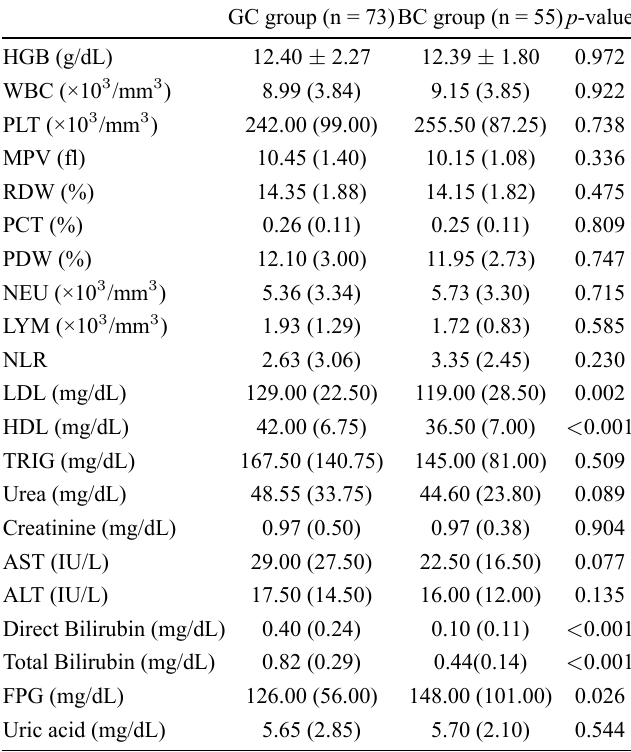
Table 2. Results of biochemical measurements in the good collateral (GC) and bad collateral (BC) groups.